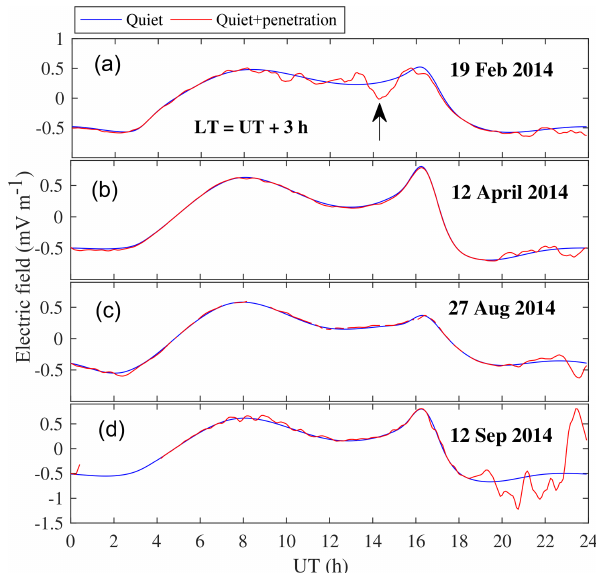
Figure 6. Prompt penetration electric field observed during storm days of (a) 19 February 2014, (b) 12 April 2014, (c) 27 August 2014 and (d) 12 September 2014. The arrow indicates time of PRE. Local time (LT) = UT +